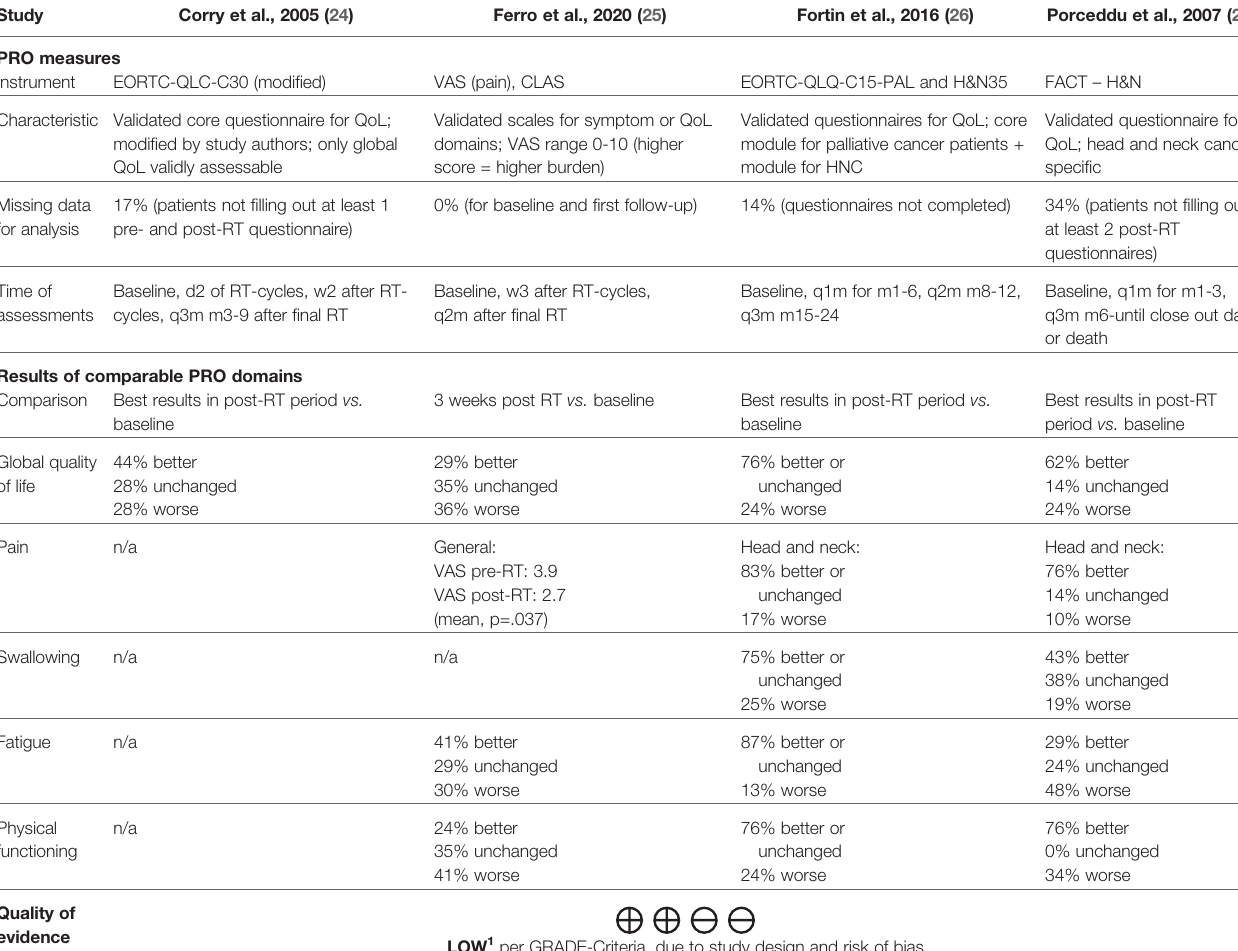
TABLE 3 | Summary of fi ndings table for patient-reported outcomes of eligible studies.